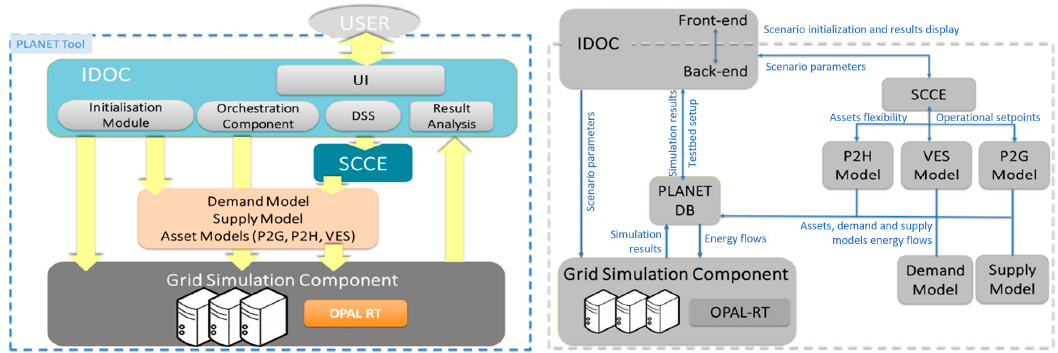
Figure 2. High-level architecture of the PLANET (PLAnning and operational tools for optimizing energy flows and synergies between energy NETworks) tool: components and exchanged information [22].